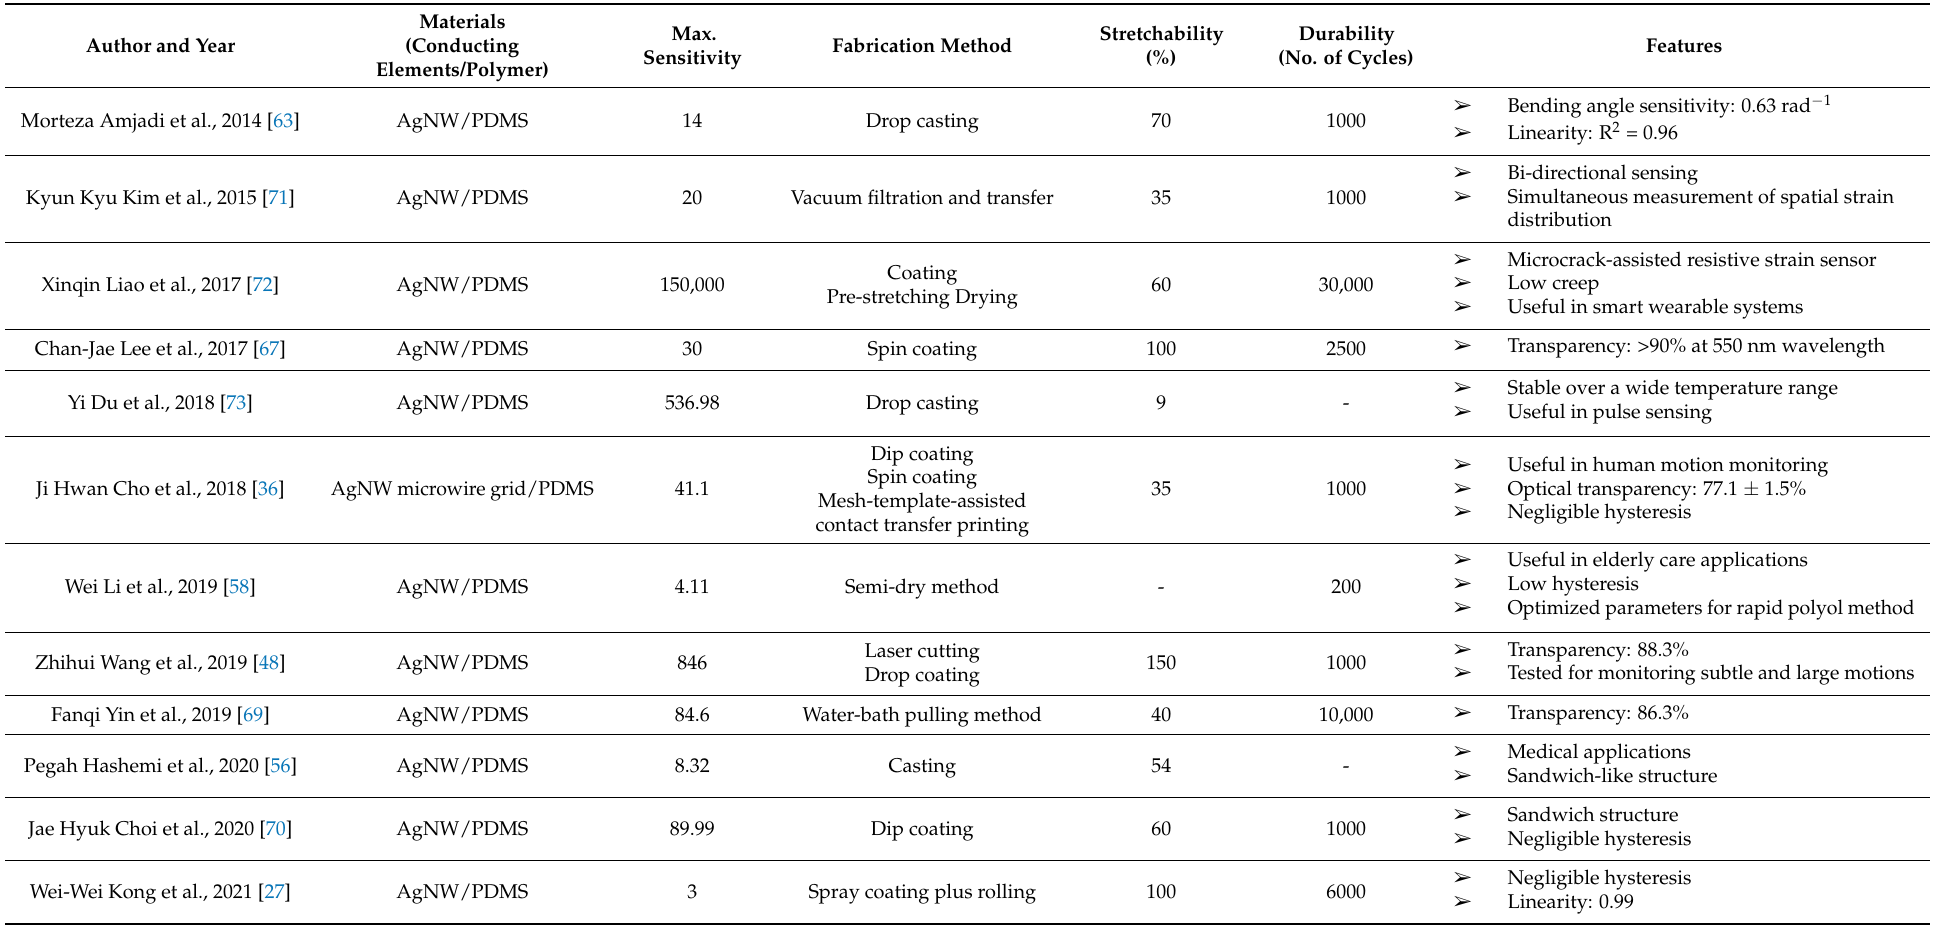
Table 1. An overview of stretchable strain sensors fabricated using AgNWs as the only filler in the PDMS